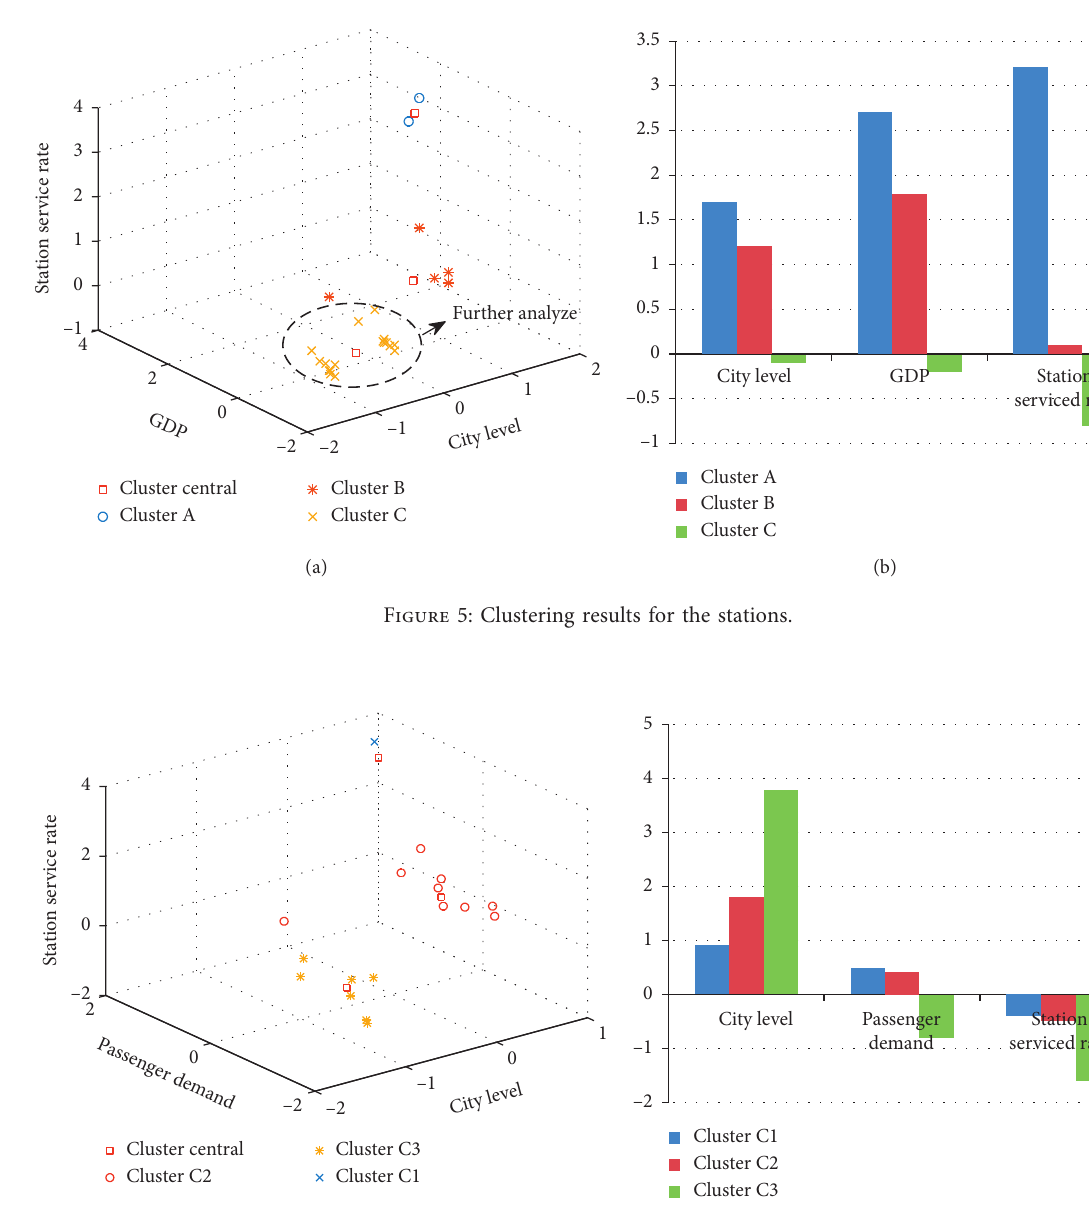
Figure 6: Clustering results for cluster C.